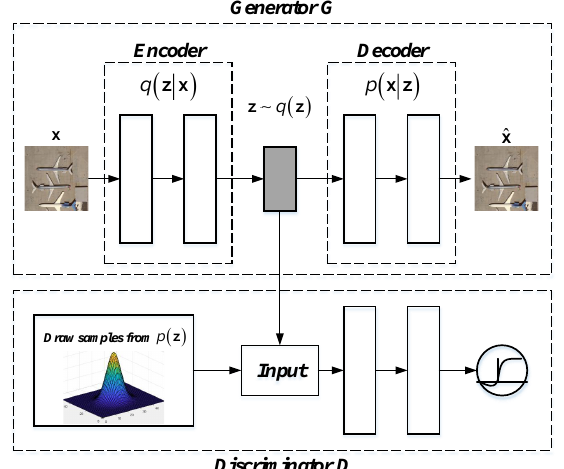
Figure 2. Framework of basic adversarial auto-encoder